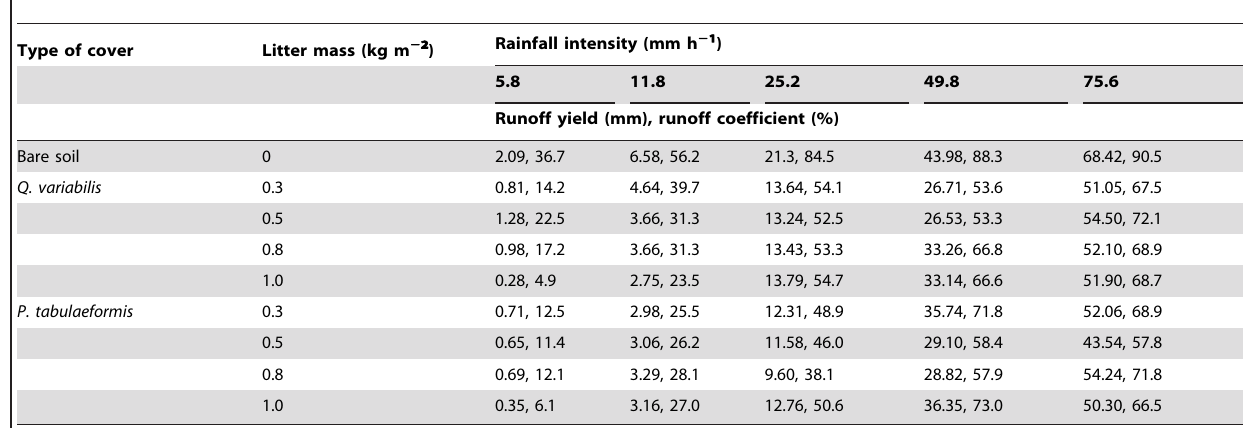
Table 3. Runoff yield and runoff coefficient data corresponding to each treatment and simulated rainfall event.